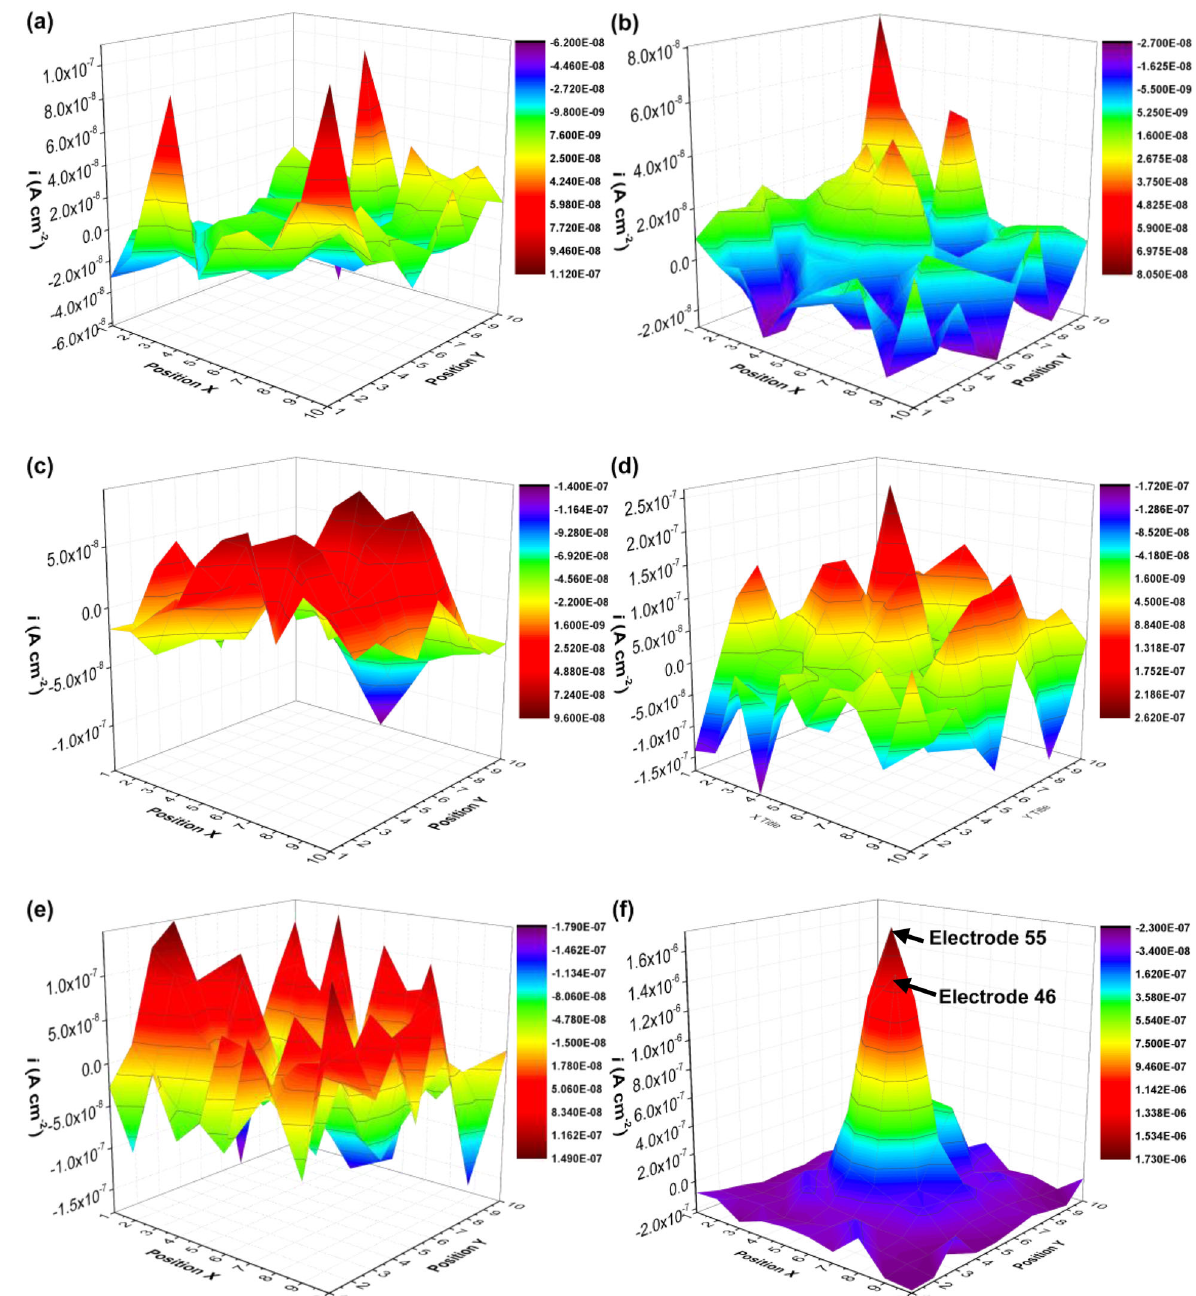
Fig. 8 The changes of distributions of galvanic current density for the typical WBE with an initial spore concentration of 10 8 spores mL − 1 . a 1 d, b 2 d, c 4 d, d 7 d, e 10 d, f 14